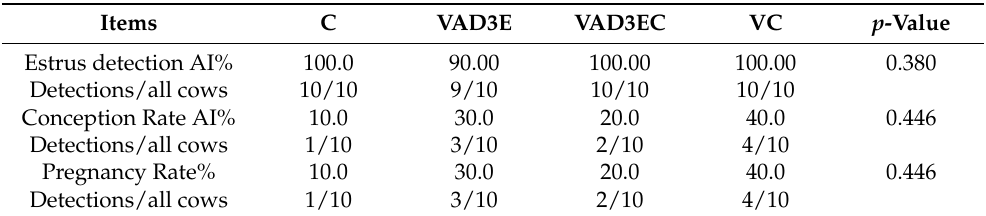
Table 2. Effects of various vitamins on estrus detection, conception rate, and pregnancy rate in dairy cows over 60